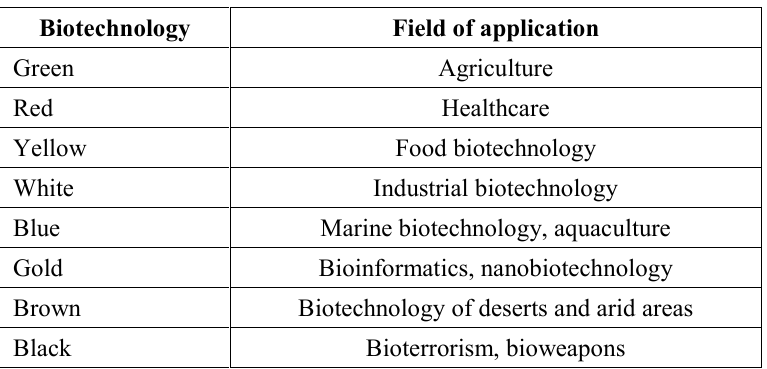
Table 1. Areas of Biotechnology Application